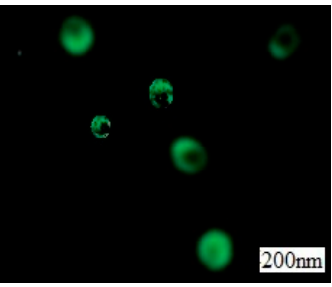
Figure 20. Schematic diagram of fluorescence microscope of amphiphilic Janus nanoparticles.